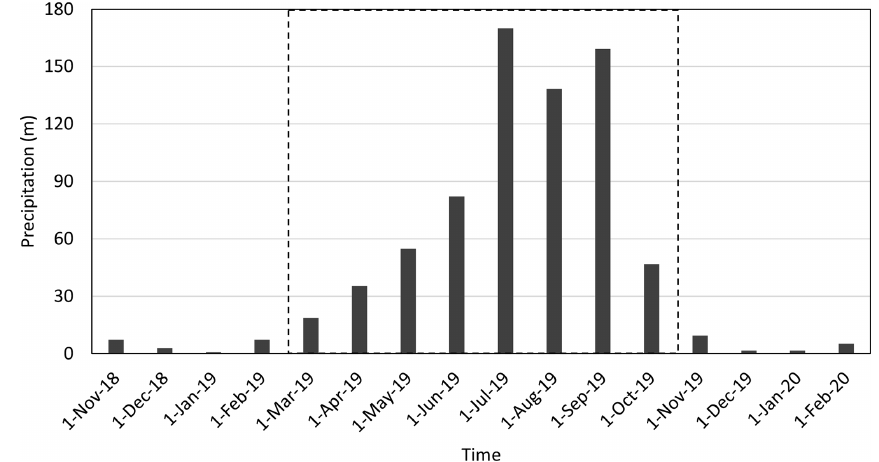
Figure 10. Monthly GPM precipitation near the MD-1, MD-2, and MD-3 slopes. The precipitation data were downloaded from the Google Earth